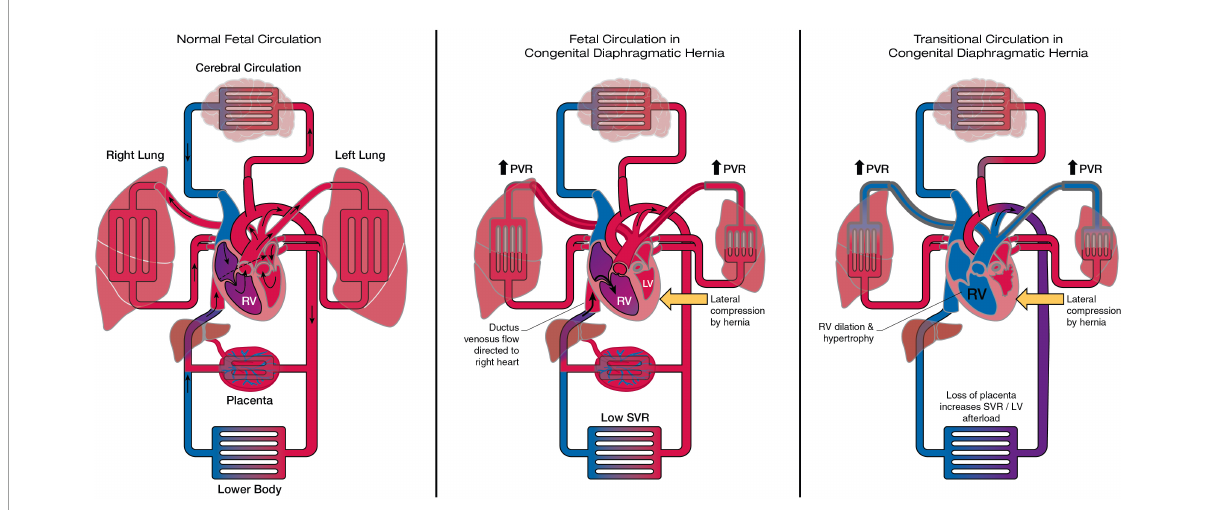
FIGURE1 The heart and circulation in CDH during the fetal and transitional period. In the fetal CDH circulation LV hypoplasia may be related to redirection of ductus venosus flow to the right heart and reduced pulmonary blood flow, together with lateral compression by the herniating abdominal contents. In the transitional period removal of the placenta increases afterload on the ventricles. The right ventricle dilates and becomes dysfunctional in the face of sustained postnatal increase in PVR. LV function is at risk due to pre-existent hypoplasia, septal displacement and the acute increase in afterload. RV, right ventricle; LV, left ventricle; PVR, pulmonary vascular resistance; SVR, systemic vascular